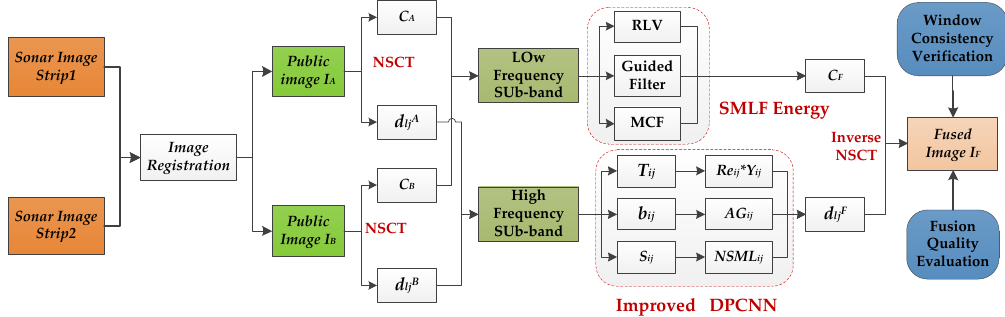
Figure 1. Flowchart of the proposed fusion method. C A/B/F is represented as the low frequency sub-band image. d ljA/B/F is denoted as the high frequency sub-band image. The characters in the matrix are representative values of key parameters in the proposed fusion criteria. NSCT, nonsubsampled contourlet transform; NSML, novel sum-modified Laplacian; SMLF, SML energy filtering; DPCNN, dual-channel pulse coupled neural network; RLV, relating sum-modified Laplacian energy with visual contrast value; MCF, multi-channel filter s.